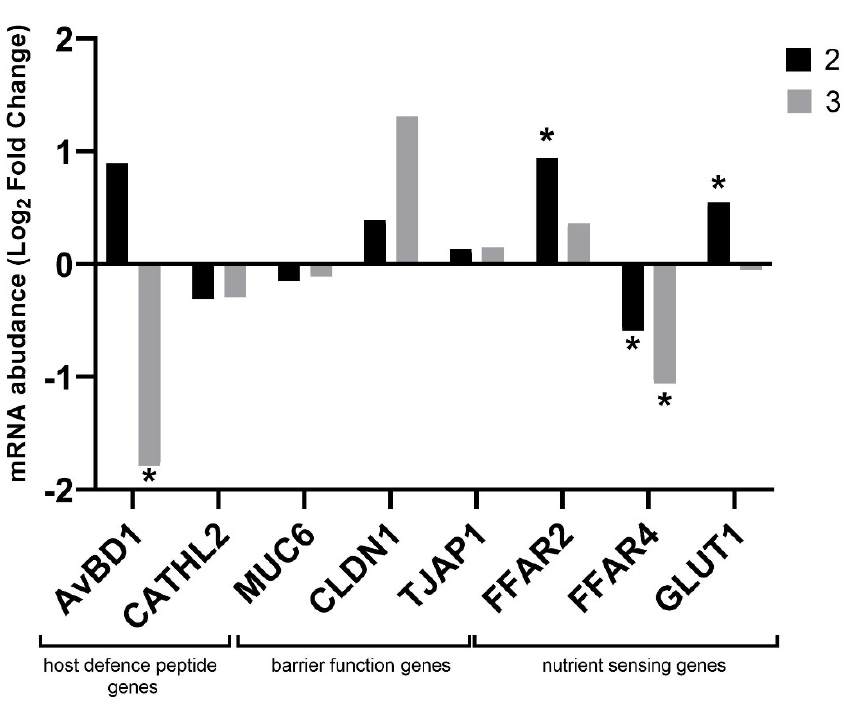
Figure 4. Relative gene expression of host defense peptide genes, barrier function genes and nutrient-sensing genes in cecal mucosa in chickens fed with the addition of halloysite and zeolite, as well as the addition of pulverized halloysite (group 2) and zeolite (group 3) to the litter. Statistical analysis consisted of comparing the experimental groups with the control group using Student’s t -test (* for p- value < 0.05).